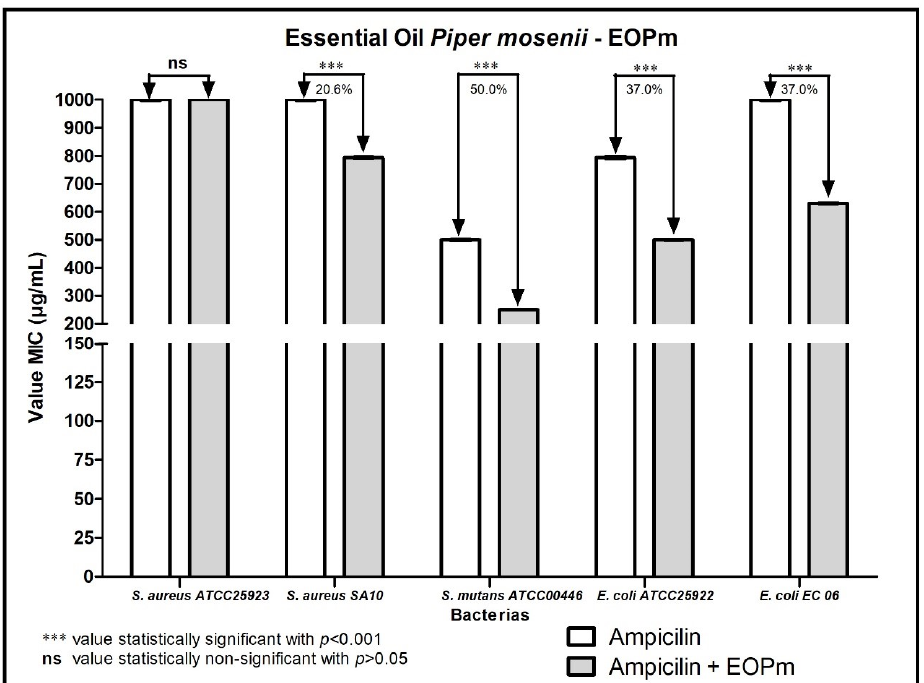
Figure 3. Evaluation of the modulatory activity of EOPm combined with Ampicillin against bacterial strains.